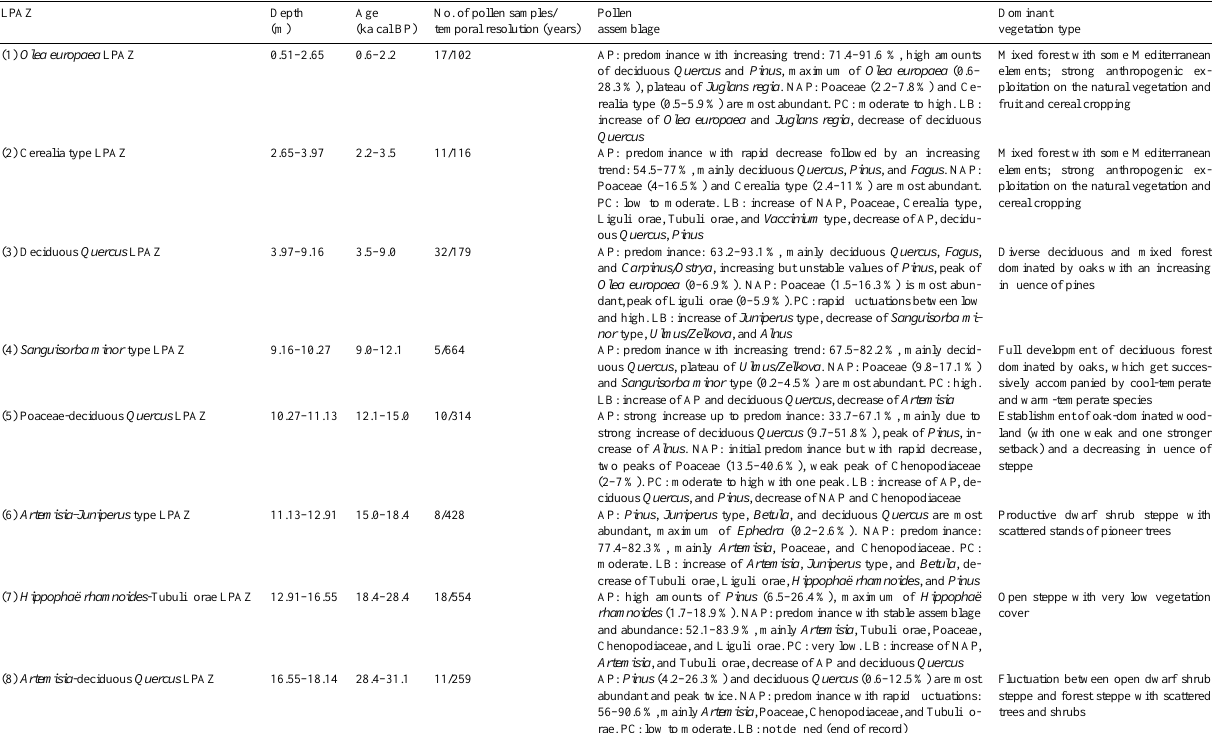
Table 2. Local pollen assemblage zones (LPAZ) with composite depths, ages, the number of pollen samples, the temporal resolution, main components of the pollen assemblage (AP: arboreal pollen, NAP: non-arboreal pollen, percentages refer to the total pollen sum and give minimal and maximal values for the respective LPAZ), pollen concentrations (PC), definitions of lower boundaries (LB), and the inferred dominant vegetation